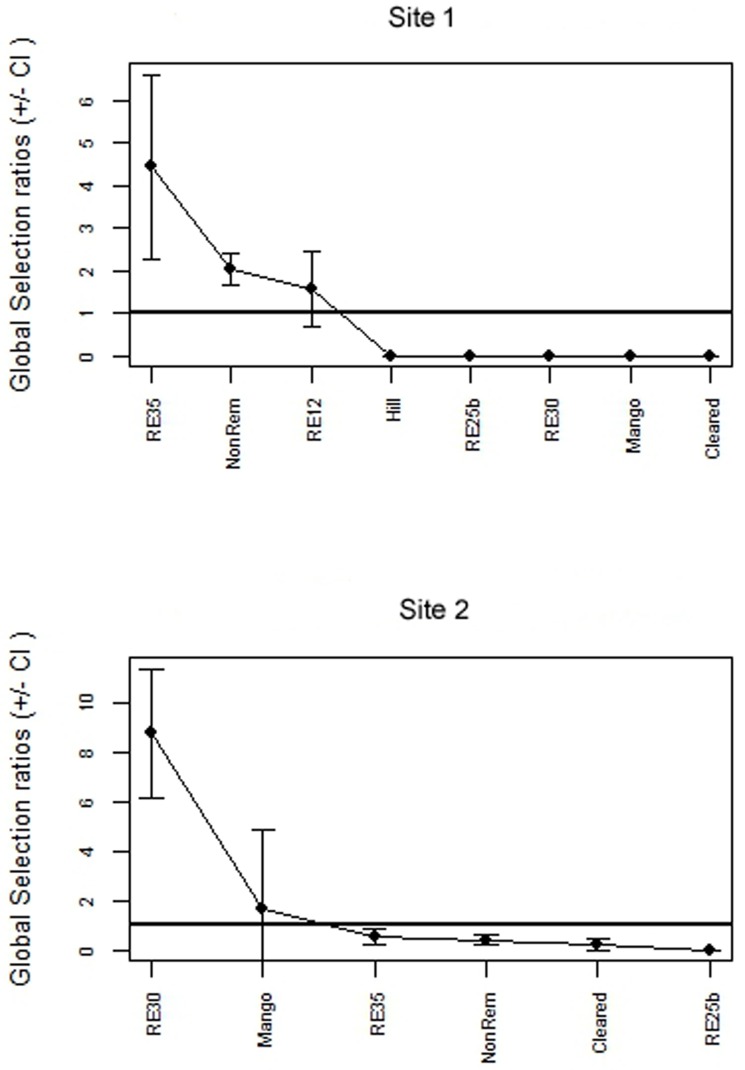
Global Manly Selection ratios ± Confidence Intervals (CI) of the vegetation types analysed in Site 1 and Site 2 for BTF in south Townsville, eastern Australia.Mean selectivity rate of each habitat type is represented by black dots (•). Habitats within Global Selection ratios in the interval 0–1 are considered to be avoided by the birds, while habitats larger than one are considered positively selected.